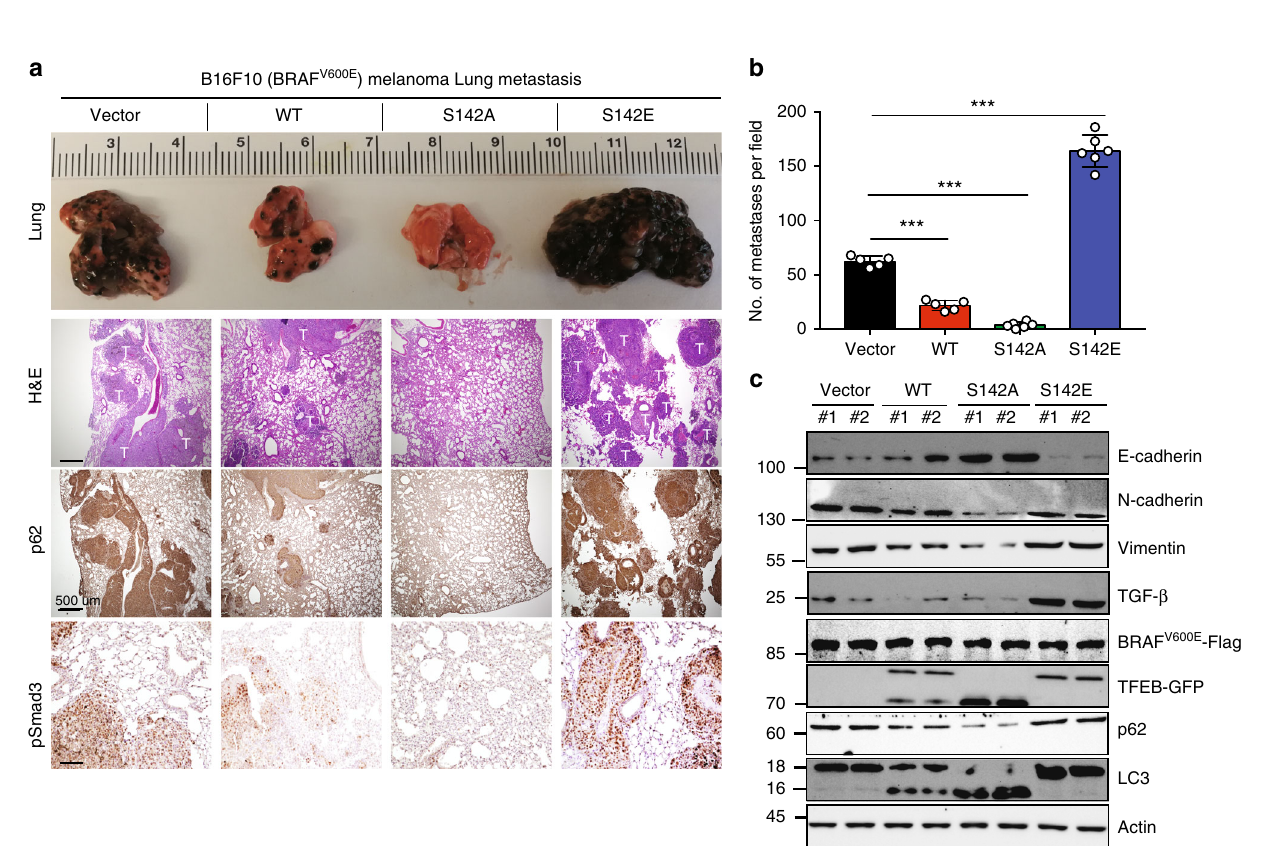
Fig. 6 TFEB S142 phosphorylation promotes the dissemination of BRAF V600E melanoma cells. a Representative gross images (top row), H&E-stained section (second row), and immunohistochemical (IHC) staining of p62 and p-Smad3 in lung metastasis of B16-F10 melanoma cells stably expressing BRAF V600E along with the indicated TFEB proteins. T metastatic melanoma tumors. b Quanti fi cation of the numbers of lung metastasis formed by B16-F10 melanoma cells as indicated ( n = 5 – 6 mice per group; data represent mean ± SD). Comparisons were made (vs. Vector group) using Student ’ s t -test. *** P < 0.001. c Immunoblot analyses of E-cadherin, N-cadherin, Vimentin, active TGF- β , LC3 conversion, and p62 in indicated lung metastases (two randomly chosen samples per group; similar results were observed in all 10 – 12 samples per condition). Actin served as a loading control. n = 3 independent experiments. See Supplementary Fig. 13 for uncropped data. Scale bars, 500 μ m. Data in c are from one experiment that is representative of three independent experiments. For all quanti fi cation, data represent the mean ± SD derived from the indicated number of independent experiments. Comparisons were made using Student ’ s t -test. *** P <